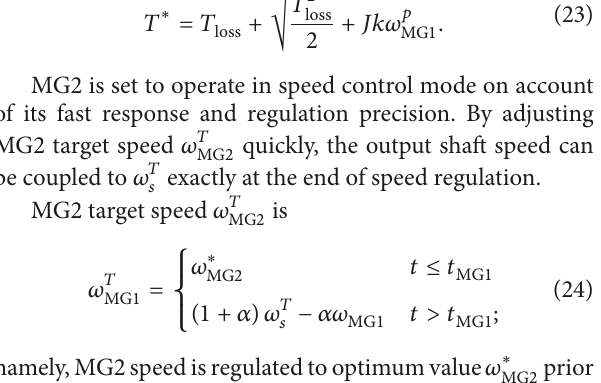
And the total MG1 speed regulation time is 𝑡 MG 1